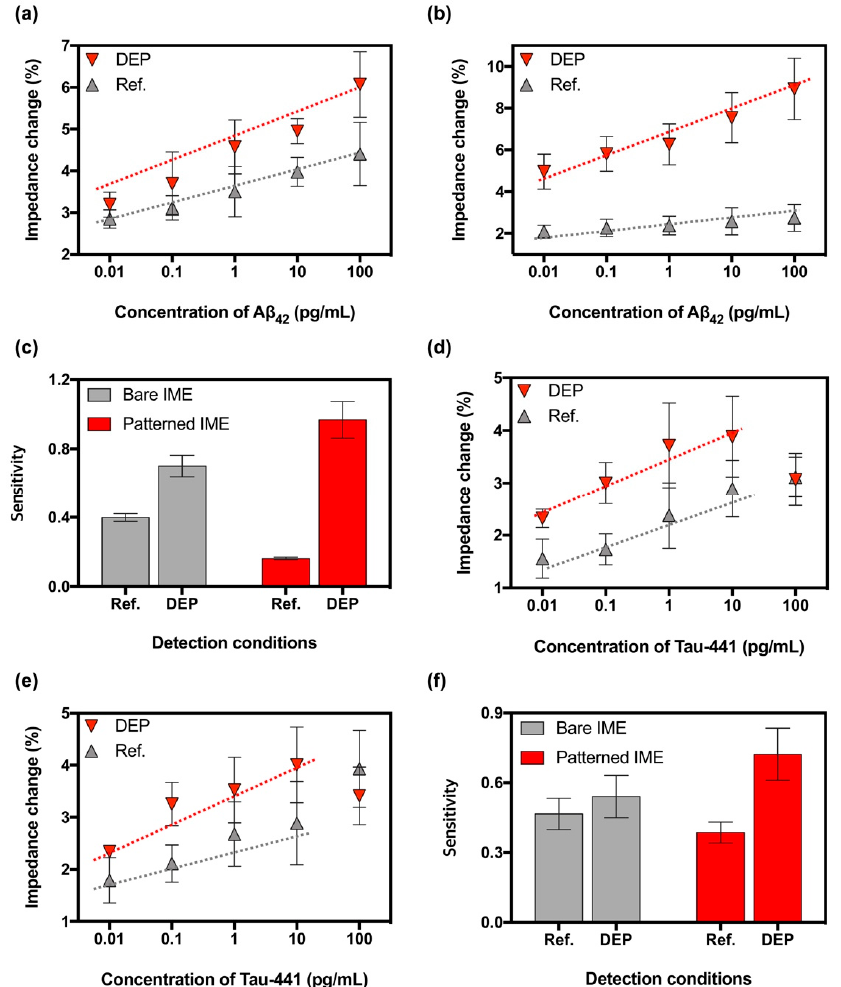
Figure 5. Impedance changes measured in ( a ) the bare IMEs and ( b ) the patterned IMEs, respectively, depending on various concentrations of A β 42 in “DEP” (red) and “Ref” (gray). Dotted lines represent a regression with linearity to estimate the sensitivity. Error bars indicate standard deviations from minimum of 5 independent measurements. ( c ) Sensitivities calculated by linear regression with 95% confidence of the dotted lines in the bare IMEs (gray) and the patterned IMEs (red). Error bars indicate the standard errors. In addition, impedance changes measured in ( d ) the bare IMEs and ( e ) the patterned IMEs depending on the various concentration of tau-441 in the condition of “DEP” (red) and “Ref” (gray). Dotted lines represent a regression with linearity to estimate the sensitivity. Error bars indicate standard deviations from minimum of 5 independent measurements. ( f ) Sensitivities calculated by linear regression with 95% confidence of the dotted lines in the bare IMEs (gray) and the patterned IMEs (red), respectively. Error bars indicate the standard errors.